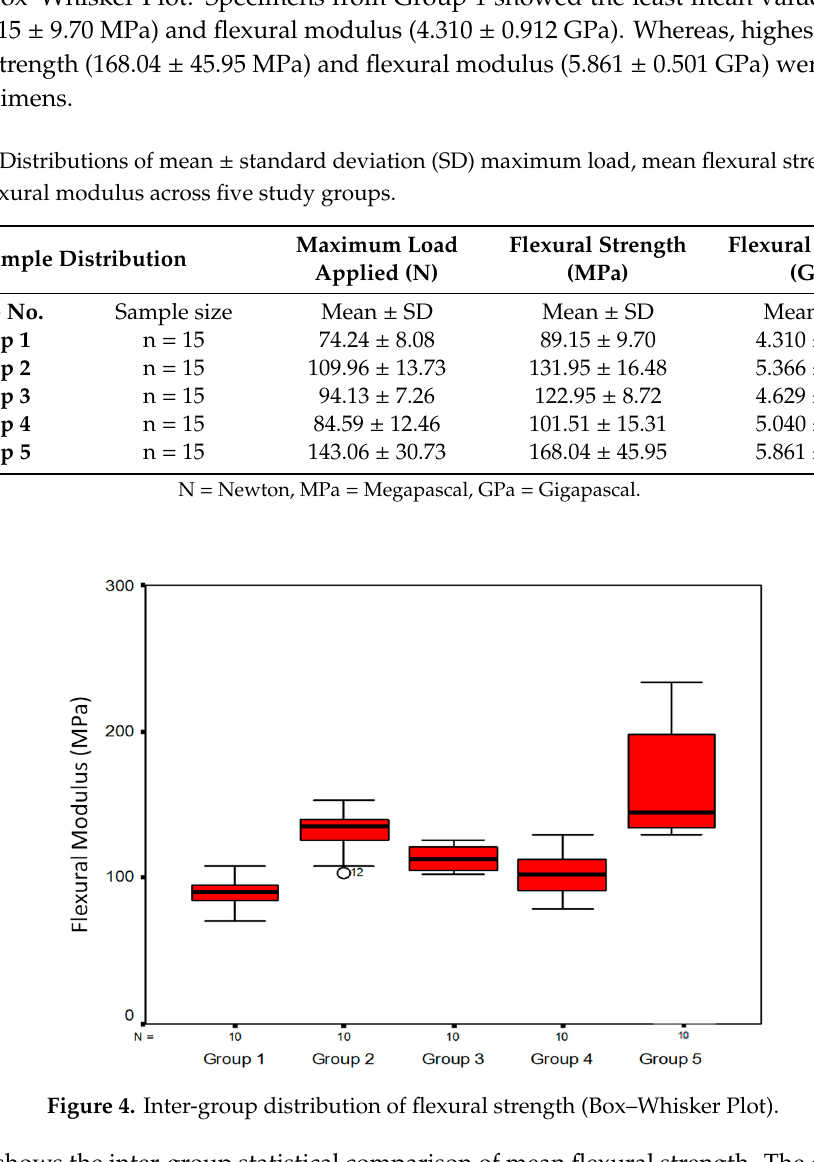
Table 2. Distributions of mean ± standard deviation (SD) maximum load, mean flexural strength, and mean flexural modulus across five study groups.